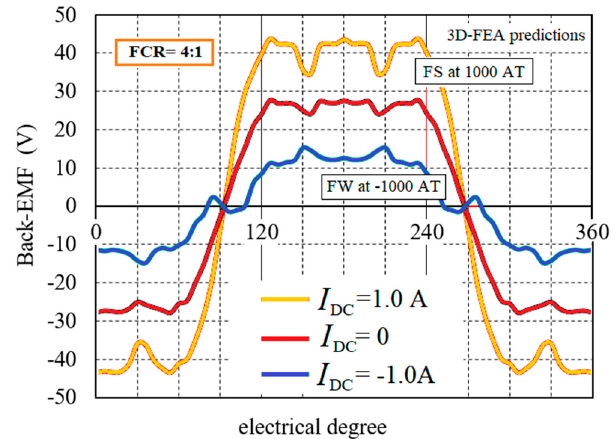
Figure 6. The 3D-FEA predictions of back-EMF waveforms at three different DC field excitations of HESM.